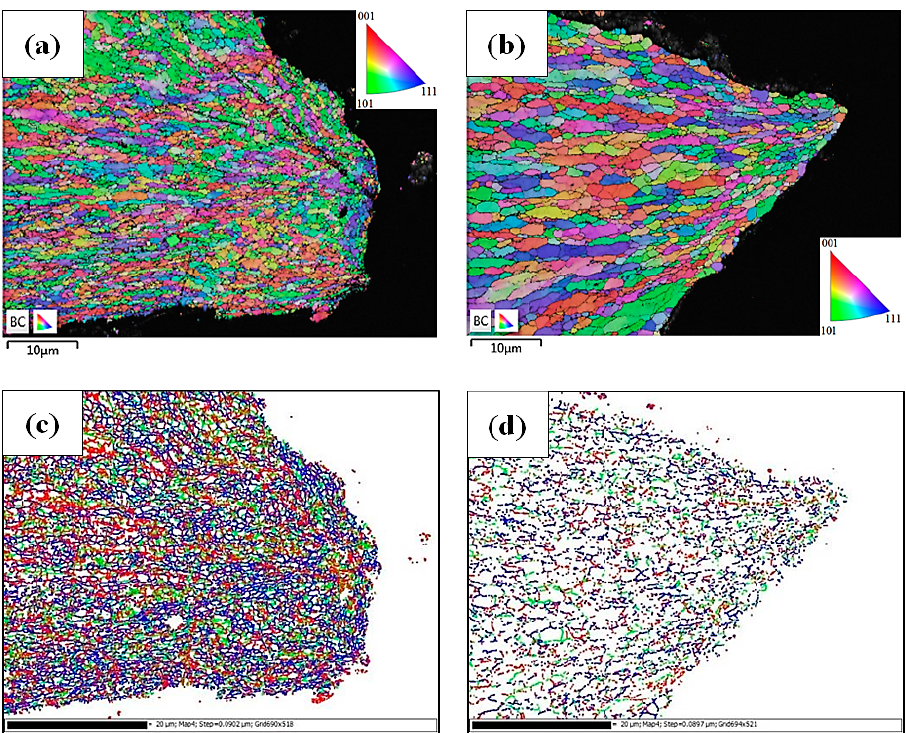
Figure 6. TEM micrographs of the ( a ) 1060NT-OT, ( b ) 940NT-OT and ( c ) 1060NT-PT samples.